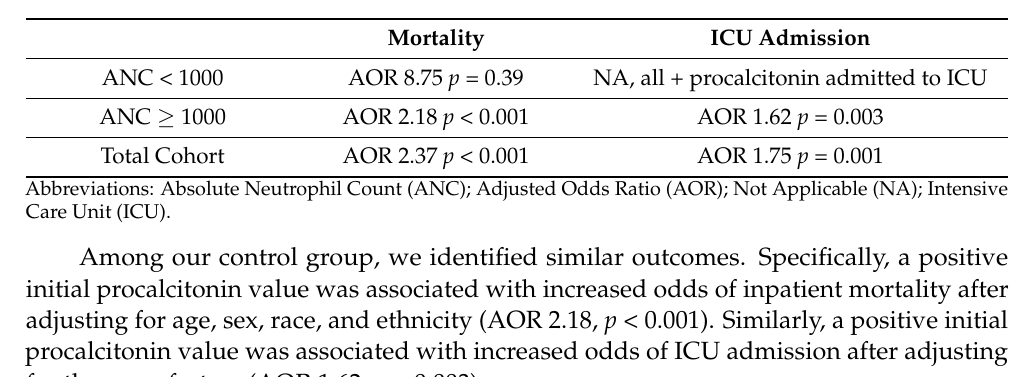
Table 2. Odds of mortality and ICU admission for patients with a positive procalcitonin ( ≥ 0.25 ng/mL) compared to those with a negative procalcitonin.